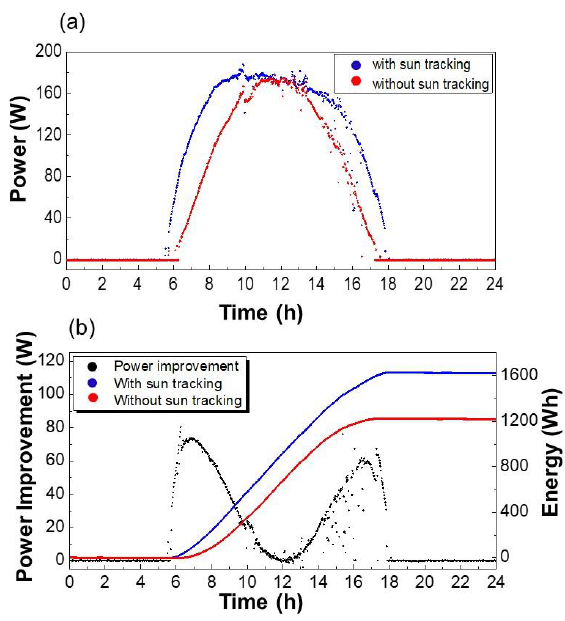
Figure 6. ( a ) Power generation and ( b ) power improvement and energy gain on a sunny day.